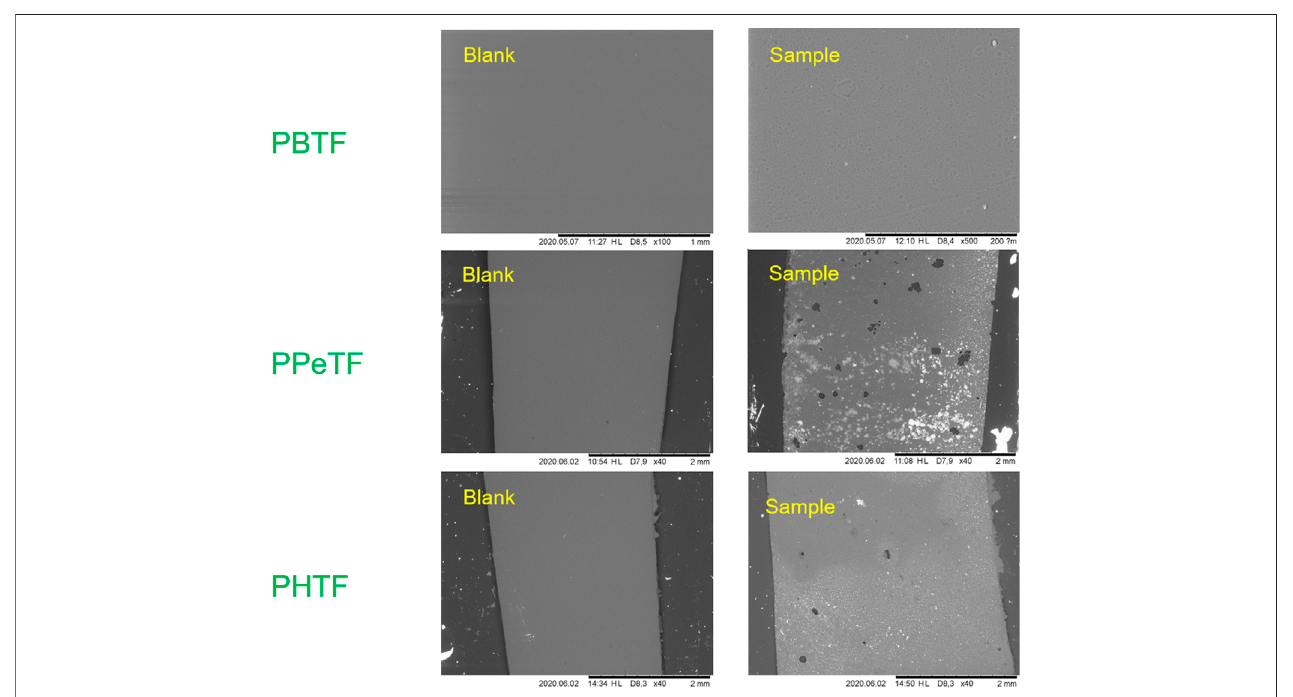
FIGURE 7 | Scanning electron microscopy (SEM) imaging of TPCA-based polyester fi lms after enzymatic hydrolysis. Right side shows the fi lms after enzymatic hydrolysis with Thc_cut1 in 1 M KPO buffer pH 8 at 65 ° C; left side shows the control reactions.